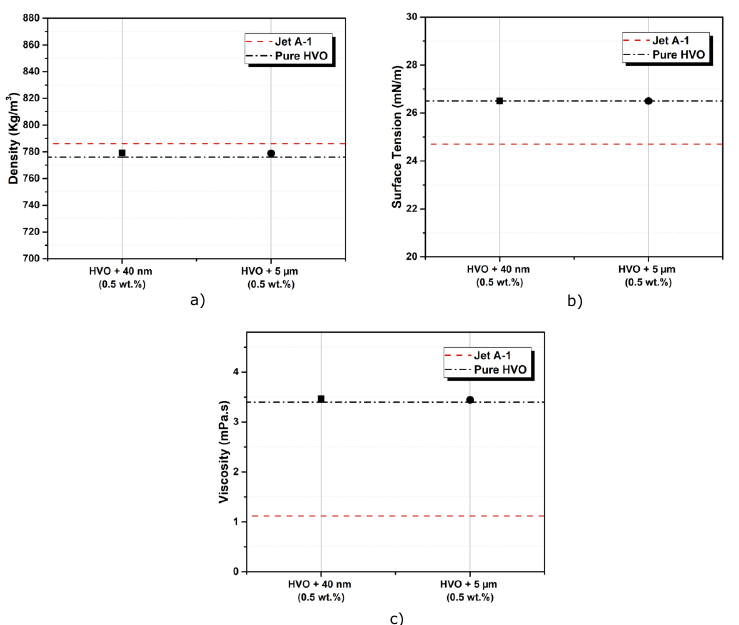
Figure 5. Physical properties of the fuels used in the present work, ( a ) density, ( b ) surface tension and ( c )